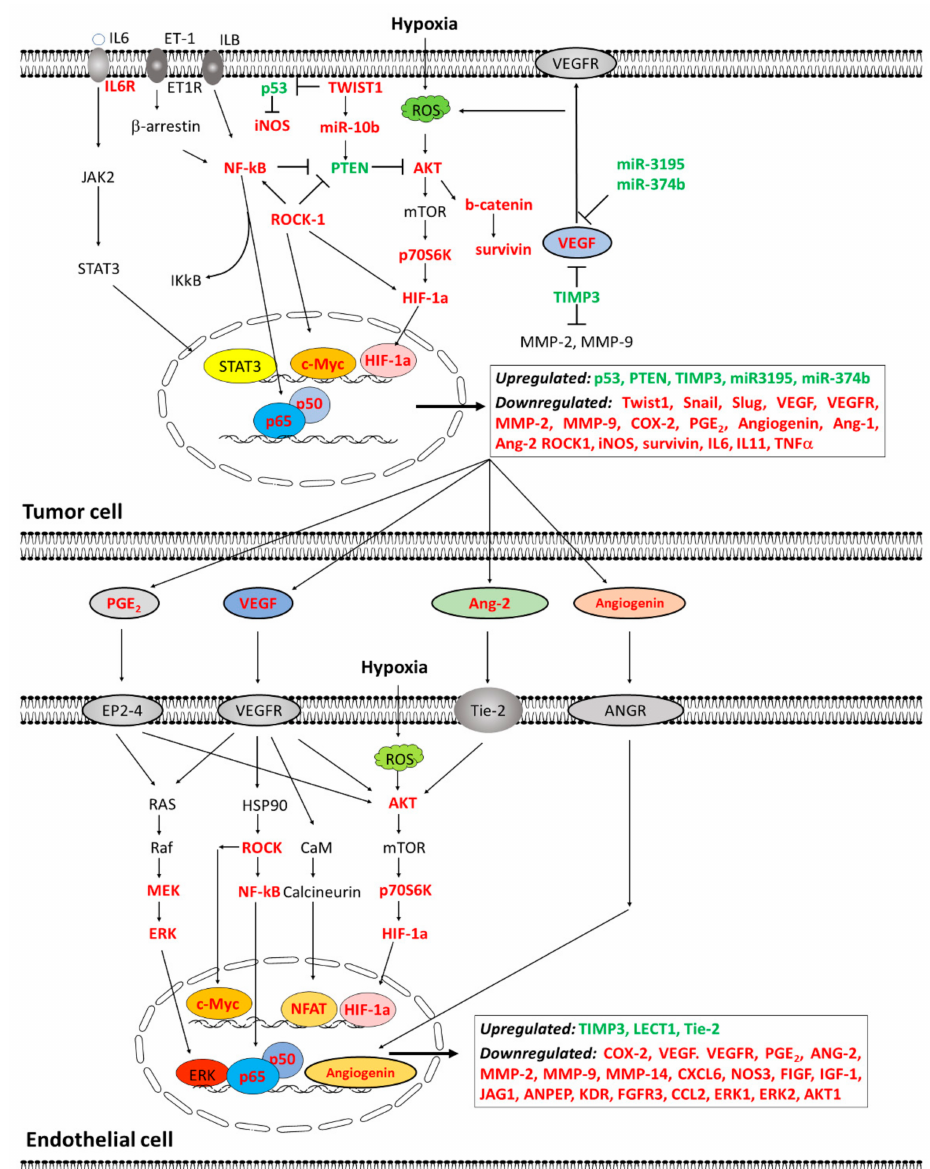
Figure 3. Proposed model of the pathways modulated by melatonin either in the tumor cell or the endothelial cell. In tumor cells, melatonin reverts the induction by chemotherapy agents of numerous EMT, pro-angiogenic, and pro-metastatic factors: Twist1, Snail, Slug, Survivin, miR-10b, COX-2, PGE2, VEGF, VEGFR, MMP2, MMP9, angiogenin, Ang-1, Ang-2, IGF-1R, ROCK-1, and HIF-1 α , whereas it stimulates tumor suppressor genes and miRNAs, such as PTEN, p53, TIMP3, miR-3195, and miR374b. Mechanistically, melatonin inhibits the AKT, NF-kB, JAK2/STAT3, or ROCK-1 signaling pathways, suppresses STAT3 activation and NF-kB nuclear translocation, and it interferes with the tumor/endothelial cell communication by diminishing PGE2, VEGF, Ang-2, and Angiogenin release. In endothelial cells, melatonin inhibits the AKT, NK-kB, ERK, Rock-1, and calcineurin/NFAT pathways, and it diminishes NF-kB, ERK, and HIF-1 α nuclear translocation, therefore reducing the expression of pro-angiogenic factors, such as COX-2, VEGF, VEGFR, PGE2, ANG-2, MMP-2, MMP-9, MMP- 14, CXCL6, NOS3, FIGF, IGF-1, IGF-1R, JAG1, ANPEP, KDR, FGFR3, CCL2, ERK1, ERK2, and AKT1, and increasing anti-angiogenic proteins, such as TIMP-3, LECT-1, or